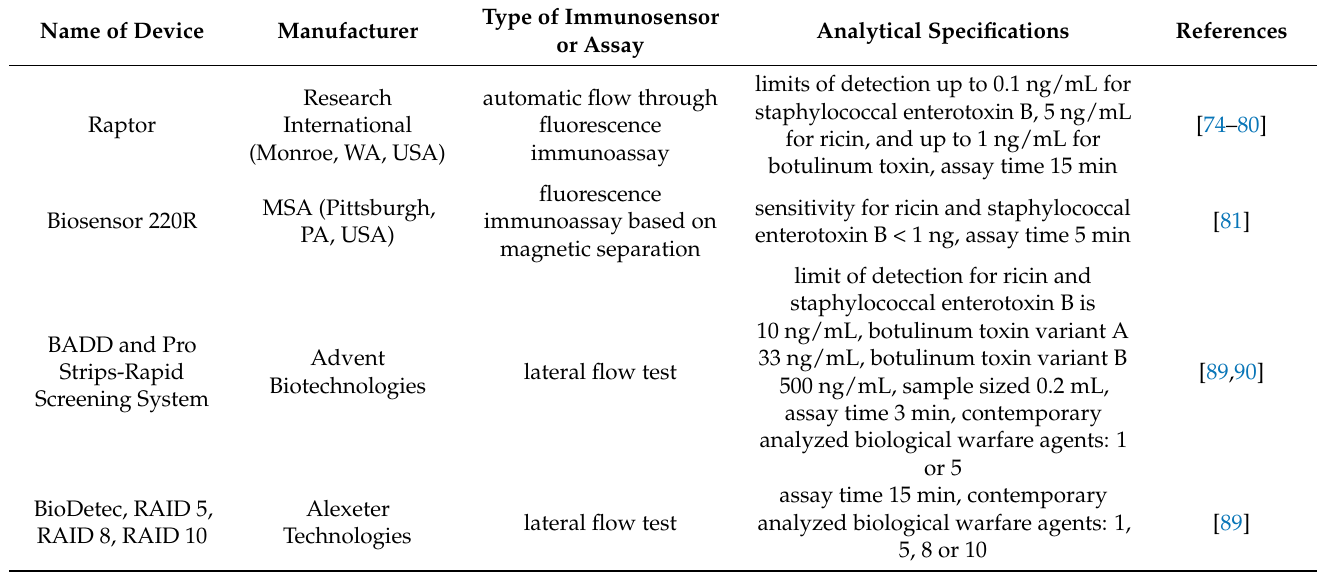
Table 2. Commercially available immunosensors for assay of toxic biological warfare